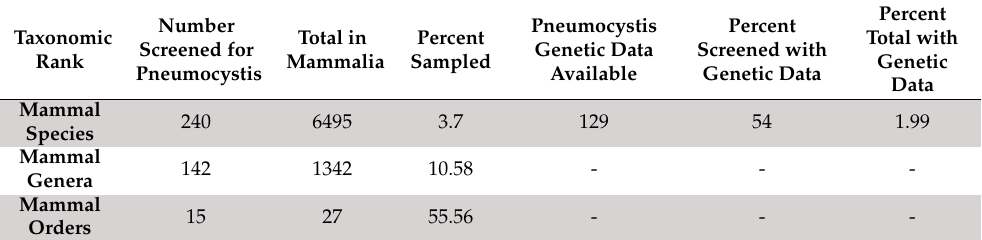
Figure 3. Representation of disparity between mean intrageneric diversity of Pneumocystis screening ( left ) and actual mean diversity of the genera sampled for Pneumocystis screening ( right ). Table 2. Summary of findings of literature search identifying all mammals screened for Pneumocystis . Number of mammal species, genera, and orders sampled for Pneumocystis screening. Percentages of total mammal diversity are shown as well as the proportion of species from which Pneumocystis genetic sequences are